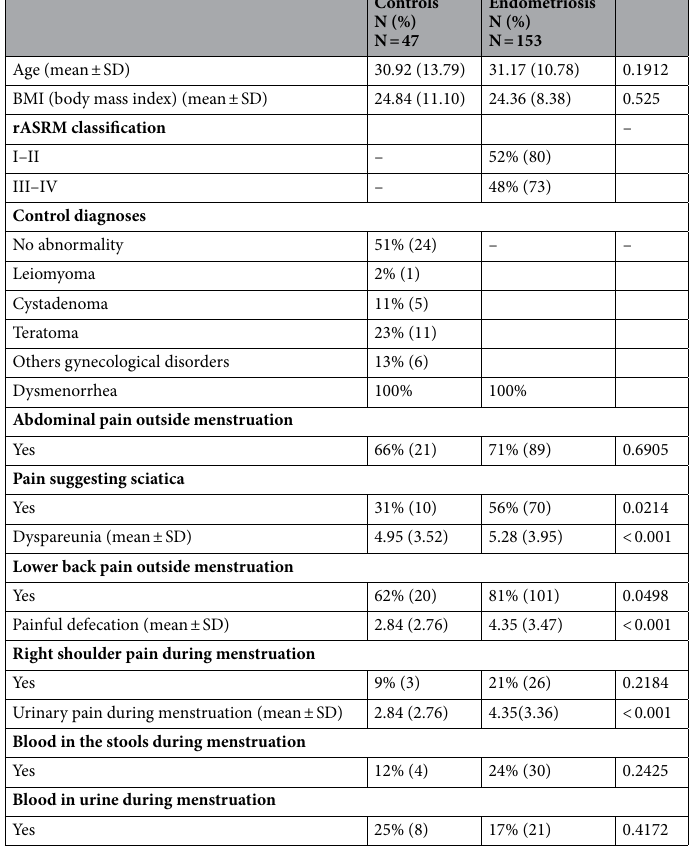
Table 1. Demographic Characteristics of the